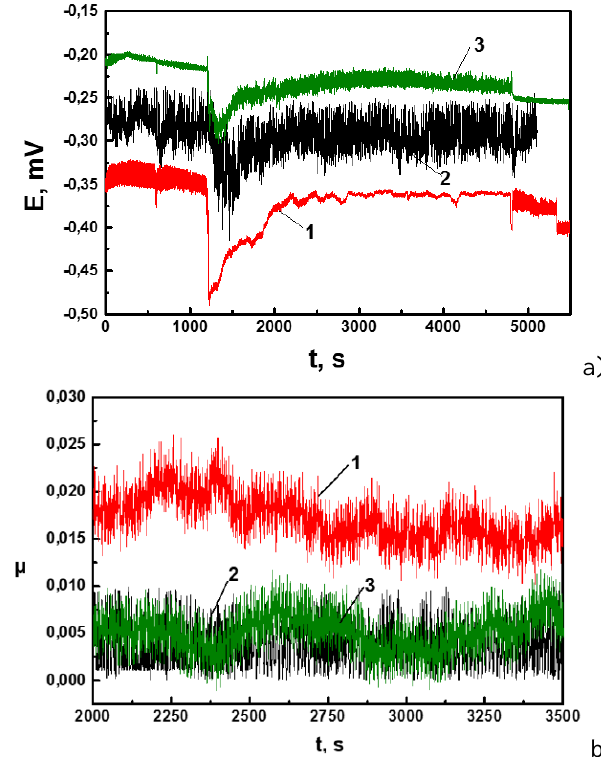
Fig.3. General changes of mixed electrode potential ( a ) and friction coefficient (b ) of friction couples steel – CEC Ni-B in the environment of glycerin + 10% NaCl at the contact loading 280 N. Friction couples – CEC Ni-B without thermal treatment ( 1 ), after vacuum annealing at 300  С ( 2 ) and 450  С ( 3